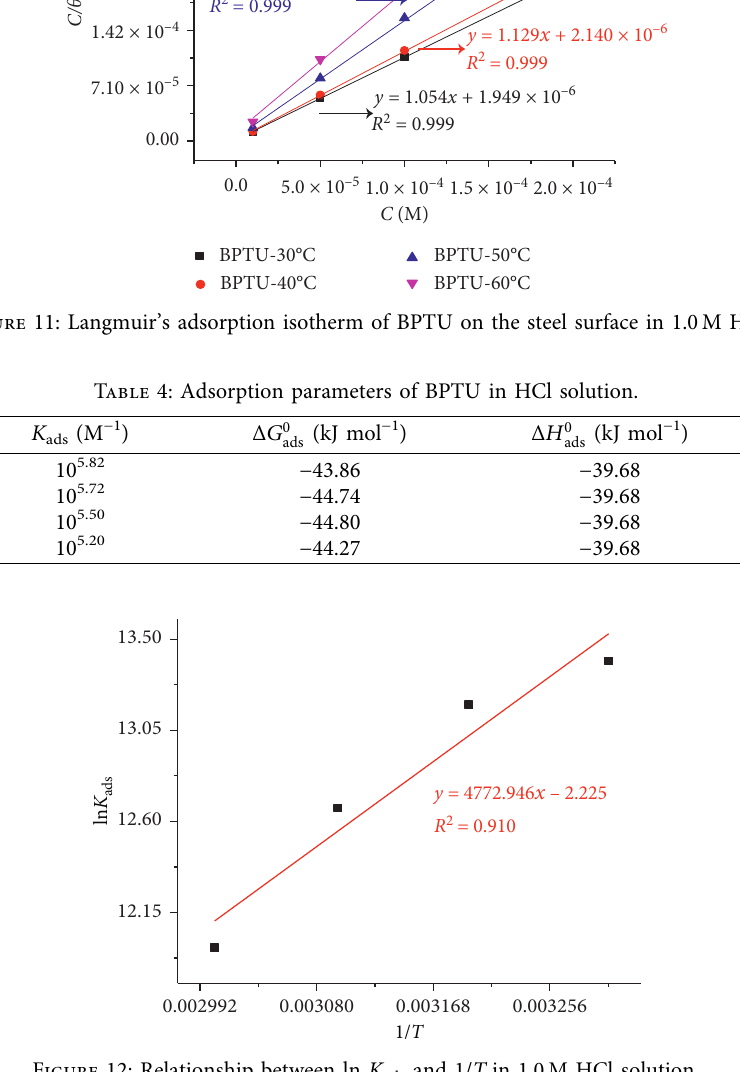
ads and 1/ T in 1.0M HCl